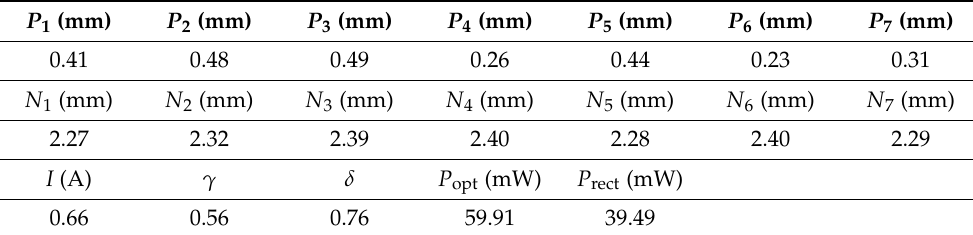
Table 3. The design parameters of the S-IVCS